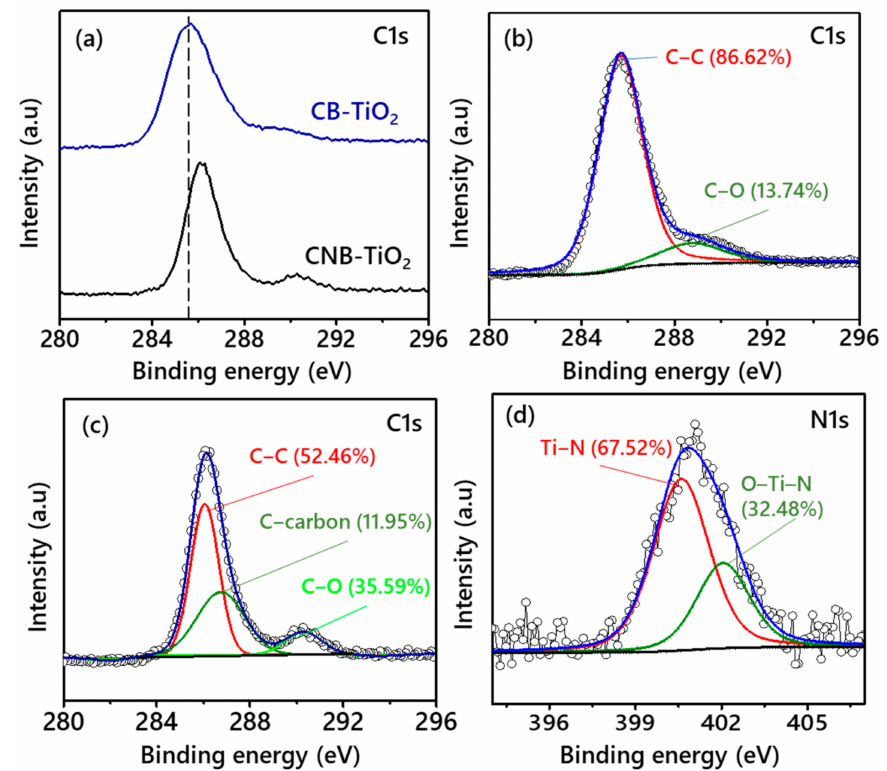
Figure 7. ( a ) Comparison of C1s spectra CB-TiO 2 and CNB-TiO 2 , ( b ) deconvoluted C1s spectra of CB-TiO 2 , ( c ) deconvoluted C1s spectra of CNB-TiO 2 , and ( d ) deconvoluted N1s spectra of CNB-TiO 2